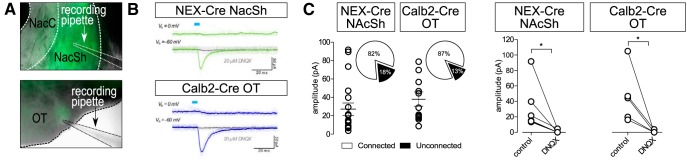
Optogenetic stimulation in striatal target areas of NeuroD6 and Calb2 VTA neurons reveals glutamatergic postsynaptic responses. A, Representative picture from patch-clamp slice electrophysiology in NAcSh of NEX-Cre mice and OT of Calb2-Cre mice injected with DIO-ChR2-eYFP. B, Representative traces of photostimulation-evoked postsynaptic currents recorded from NAcSh cells from NEX-Cre and OT cells from Calb2-Cre mice injected with DIO-ChR2-eYFP. C, Pie charts represent the percentage of cells showing EPSCs (white) versus negative (black) upon photostimulation of terminals in the NAcSh (N = 18 cells from four mice) of NEX-Cre mice, and OT (N = 14 cells from 4 mice) of Calb2-Cre mice. The y-axis shows amplitude in pA; each circle represents one cell, and bold lines the mean amplitude ± SEM. D, Patch-clamp recordings pre-bath (control) and post-bath application of DNQX upon photostimulation in NAcSh of NEX-Cre/ChR2 (left, N = 6 cells from three mice) and OT of Calb2-Cre/ChR2 mice (right, N = 5 cells from three mice). Each circle represents one cell (*p < 0.05 control vs DNQX). NAcSh, nucleus accumbens shell; OT, olfactory tubercle. Calb2, Calbindin 2 (Calretinin); NEX; NeuroD6; ChR2; Channelrhodopsin 2; eYFP, enhanced Yellow fluorescent protein.